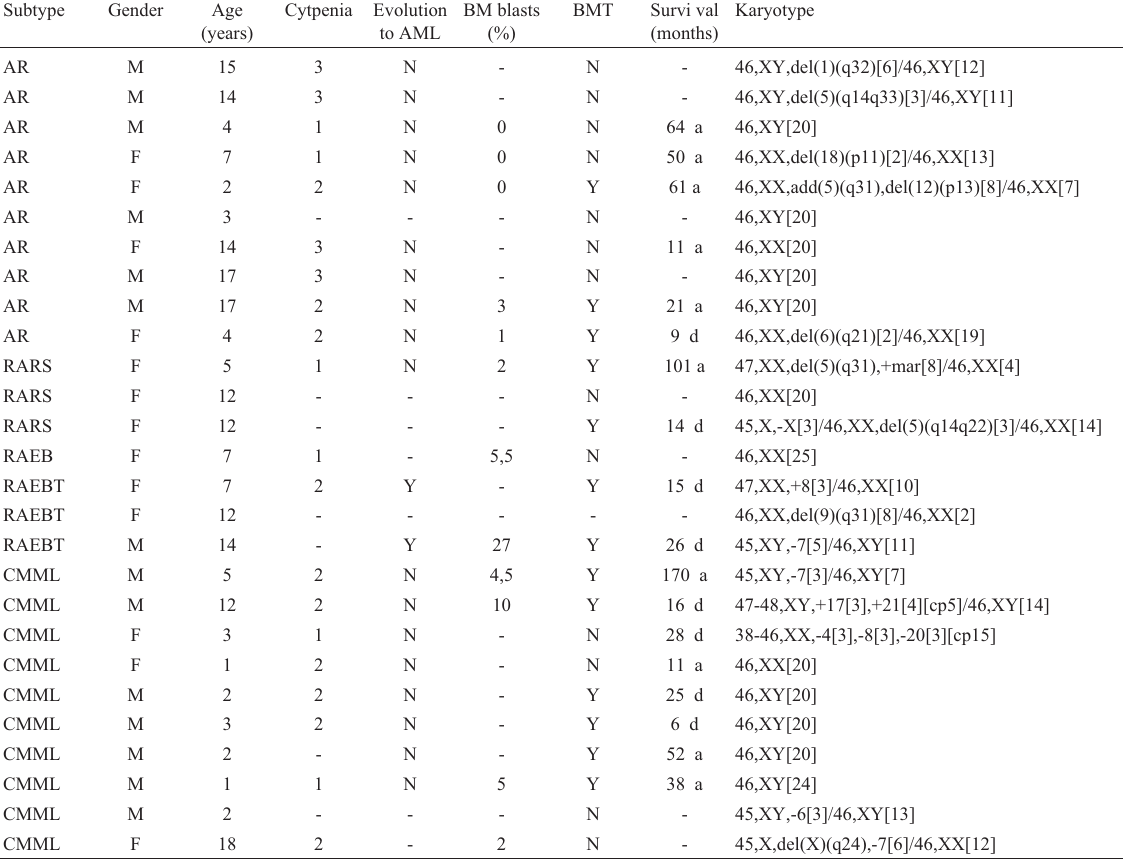
Table 2 - Clinical data and karyotype of 27 pediatric MDS